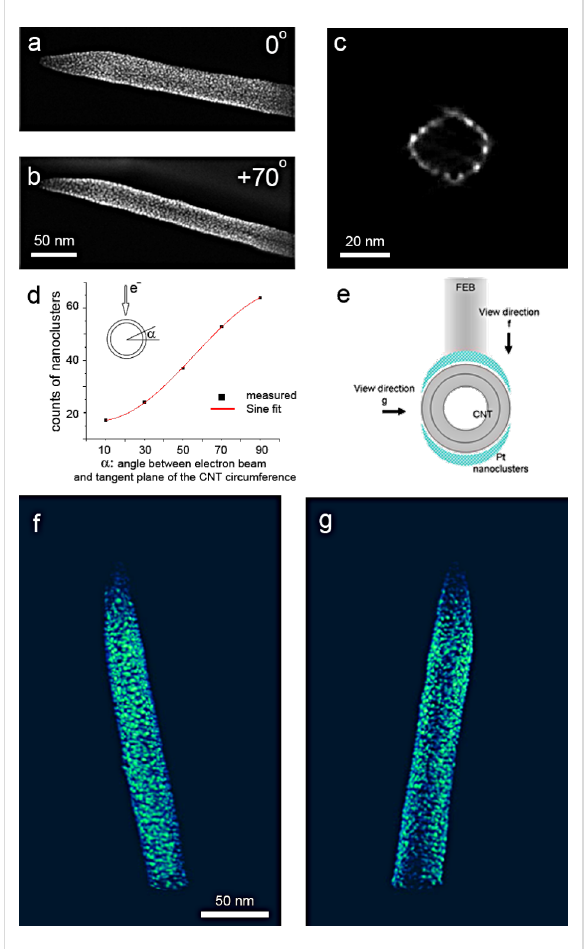
Figure 1: (a,b) HAADF-STEM images of the Pt deposited CNT at tilting angle of 0 and 70 degrees respectively. (c) A cross-section snap- shot of the Pt deposited CNT from 3D reconstruction. Pt nanoclusters are shown as bright contrast. (d) Graph showing that the circumferen- tial distribution of nanoclusters fits a sinusoid. (e) Illustration of the Pt distribution around the CNT. (f,g) Snapshots of the 3D reconstructed CNT along the viewing direction of f and g according to the illustration in (e).